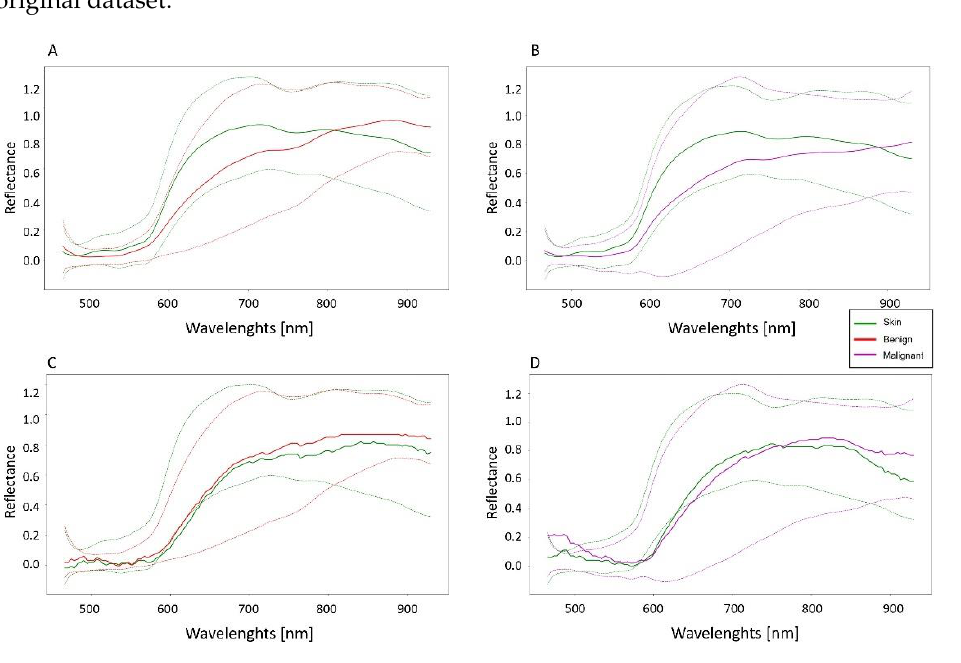
Figure 7. Comparisons between real and synthetic spectral signatures. ( A , B ) represent the real dataset spectral signatures, while ( C , D ) represent the synthetic (fake) ones after the smoothing operation. The dashed lines are twice the standard deviation ranges of the signatures, while the continuous lines represent the mean values.